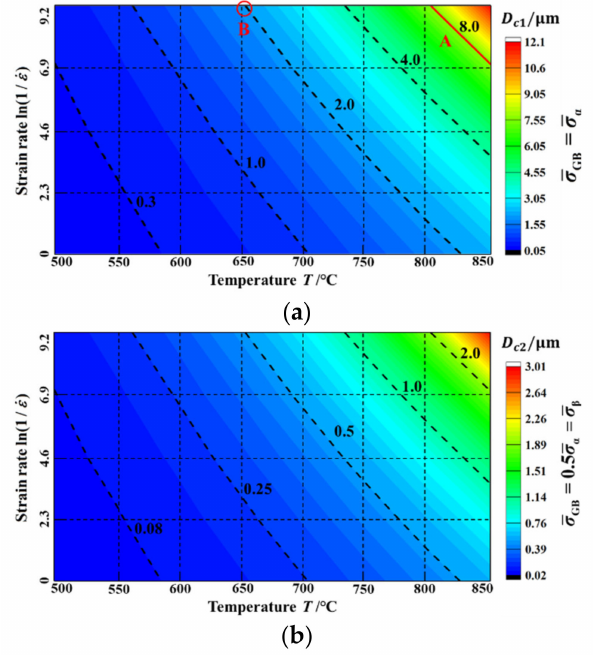
Figure 14. Critical grain size of TA15 samples when the strength of the GB region is equal to the α phase ( D c1 ) or the β phase ( D c2 ) under different hot deformation conditions. ( a ) σ GB = σ α = 2 σ β , ( b ) σ GB = 0.5 σ α = σ β .